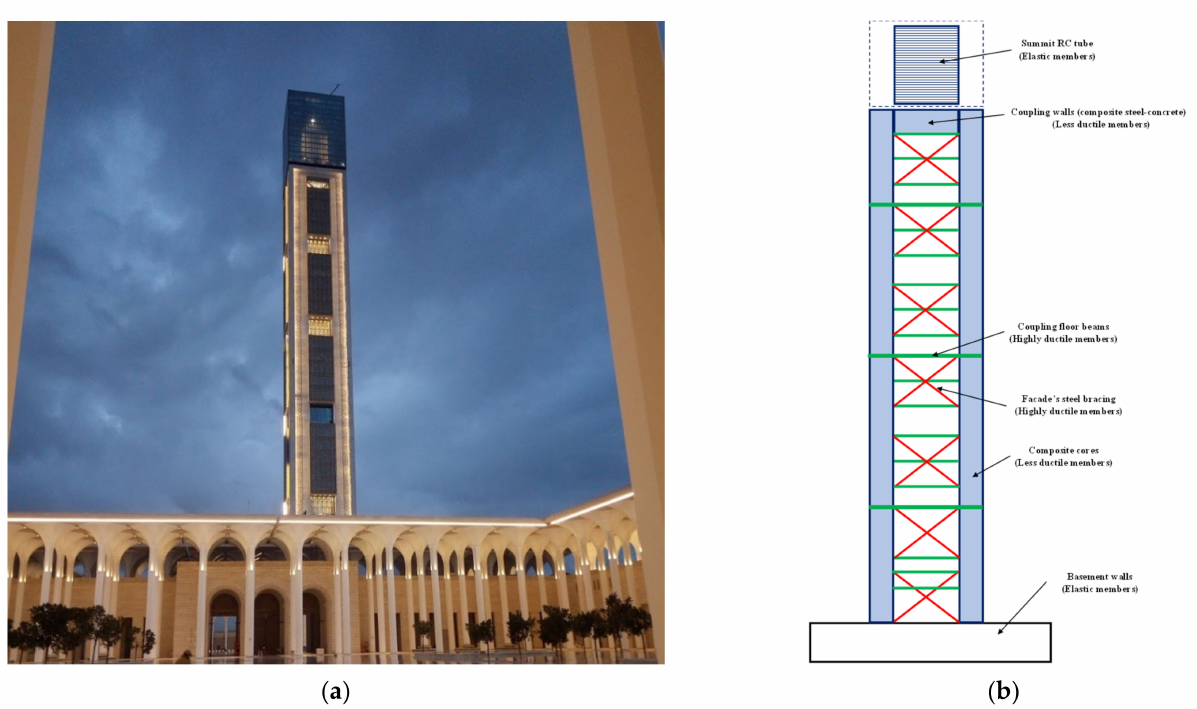
Figure 13. ( a ) General view of the Great Mosque of Algeria; ( b ) different structural members with respect to their design